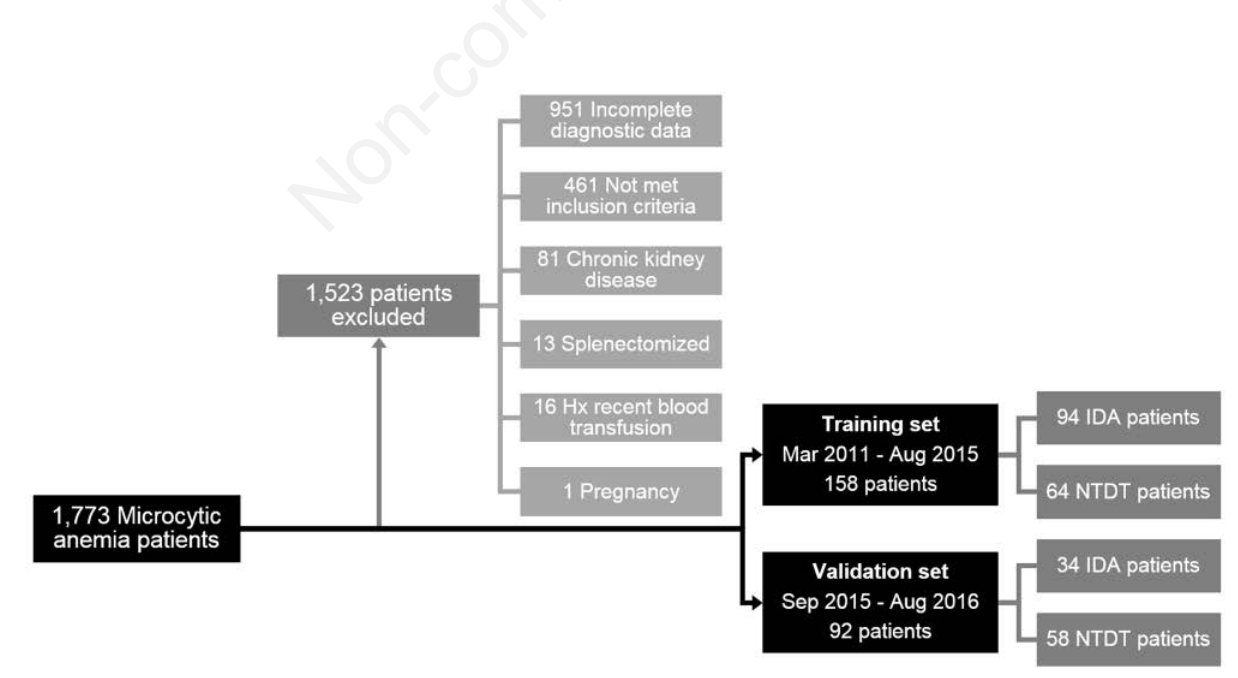
Figure 1. Study population flow.